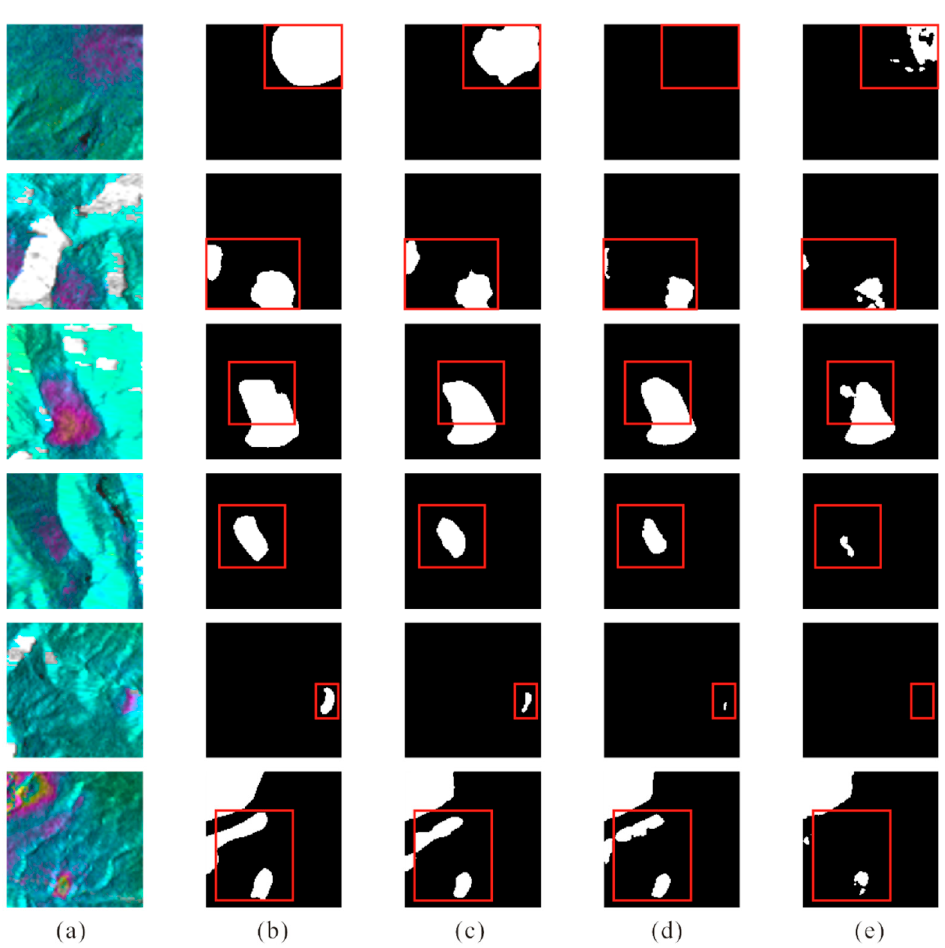
Figure 10. Recognition results of some InSAR patches from the test set; ( a ) input InSAR imagery, ( b ) corresponding ground truth, ( c – e ) recognition results of DRs-UNet, U-Net, and SegNet, respectively.